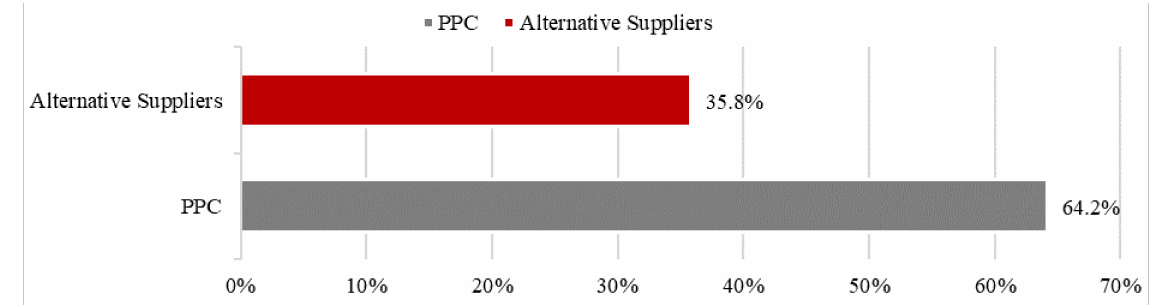
Figure 4. Retail Market Share (%), (2016–May 2021), Source: Hellenic Energy Exchange and Authors’